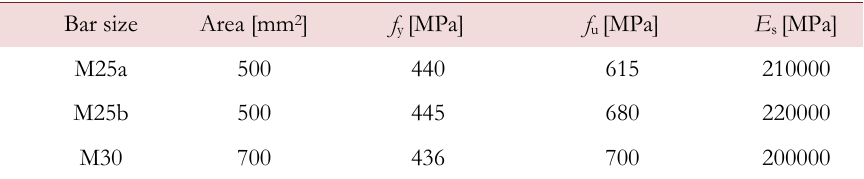
Table 1: Material properties of steels.